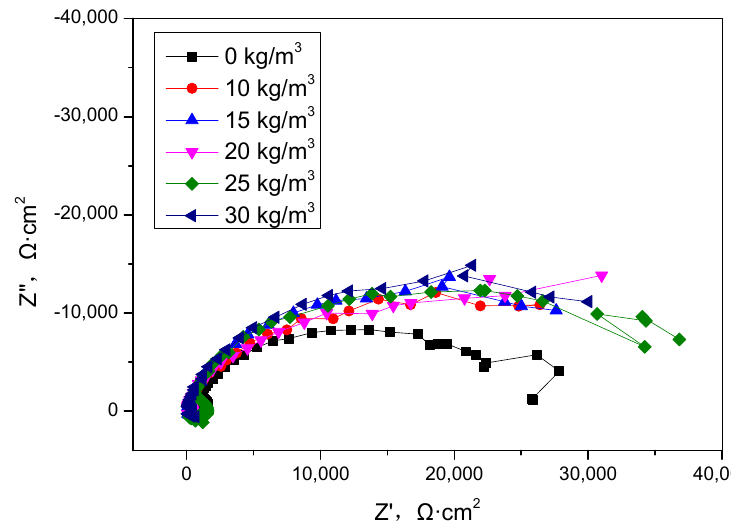
Figure 7. Effect of TIA on the corrosion behavior of steel in a simulated pore solution.